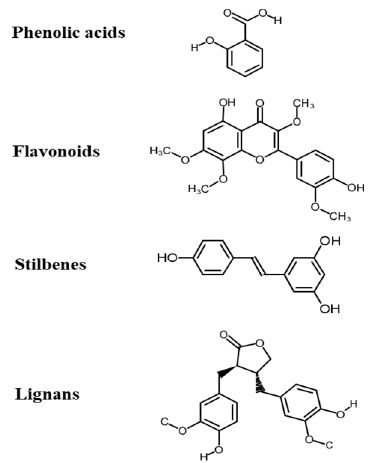
Figure 2. Chemical structures of polyphenols from four categories.